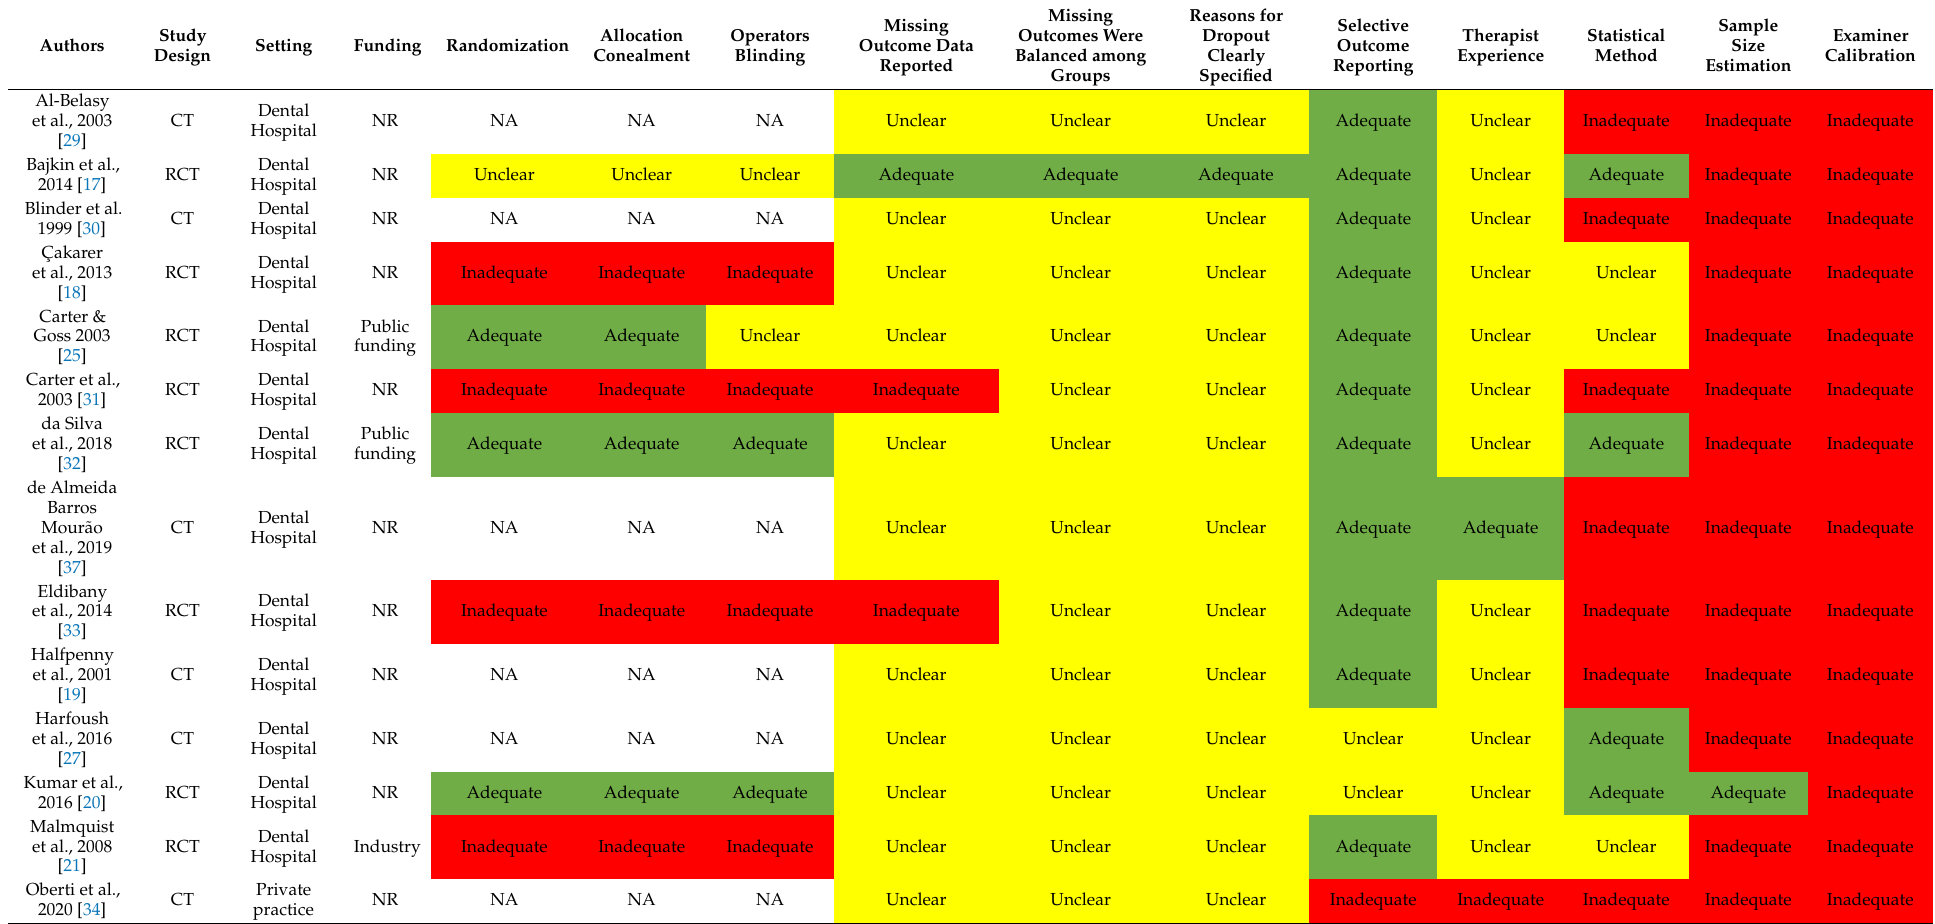
Table 2. Quality analysis of the included studies. Color coding: WHITE: not applicable; YELLOW: unclear; GREEN: adequate; RED: